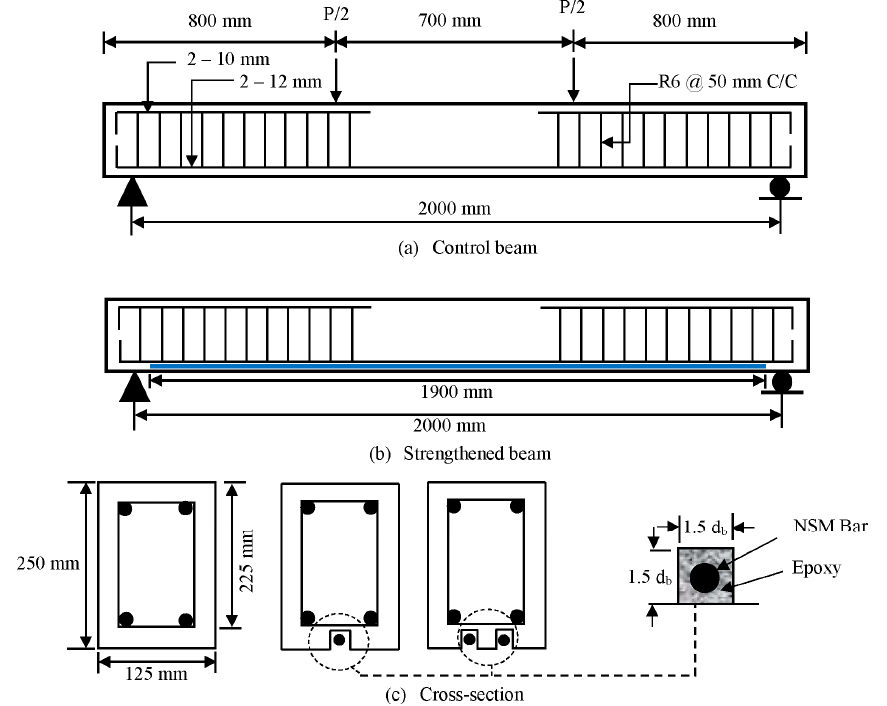
Figure 1. Beam specimen details.